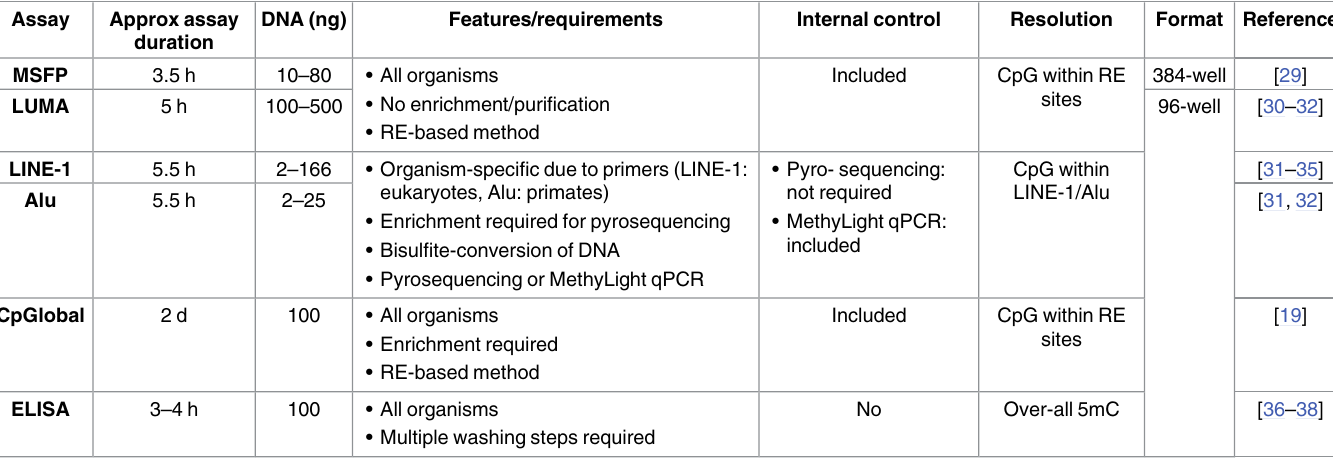
The table focuses on assay conditions, methods, and readouts downstream of the DNA purification step. Internal controls are used to normalize the input DNA amount. Abbreviations: 5mC; 5-methylcytosine, LINE-1; long interspersed nuclear element-1, LUMA; luminometric methylation assay, MSFP; methyl- sensitive fluorescence polarization, RE; restriction